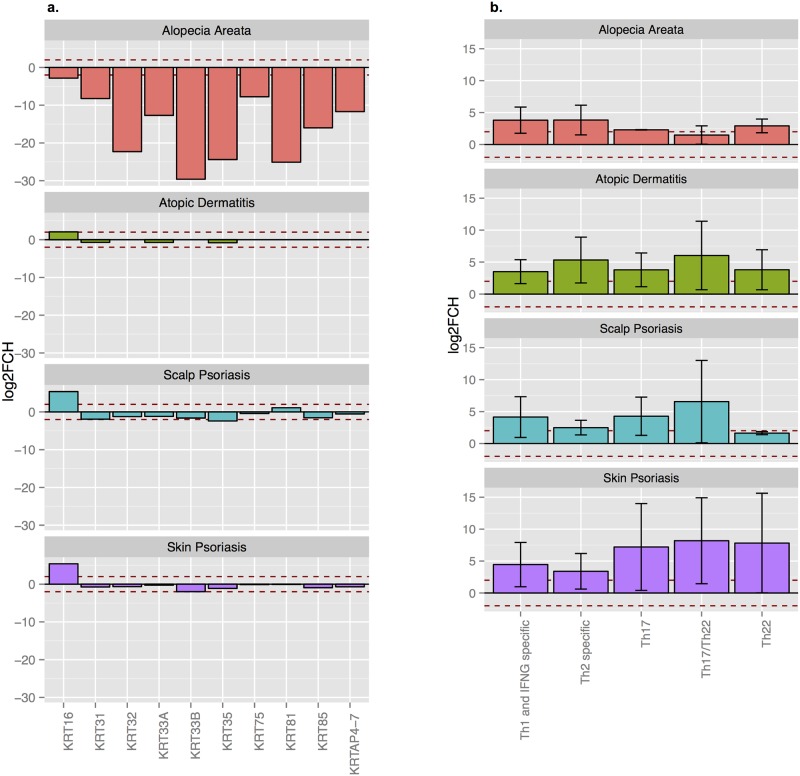
Keratin and immune-set gene expression profile of scalp psoriasis vs skin psoriasis, atopic dermatitis, and alopecia areata.Average log2FCH for alopecia areata (AA), atopic dermatitis (AA), scalp psoriasis and skin psoriasis for a representative group of (a) keratin and keratin associated proteins (KRTAPs) and (b) immune-related pathways genes adjusted by region (normalized to normal scalp [AA and scalp psoriasis] or normal skin [AD and skin psoriasis].